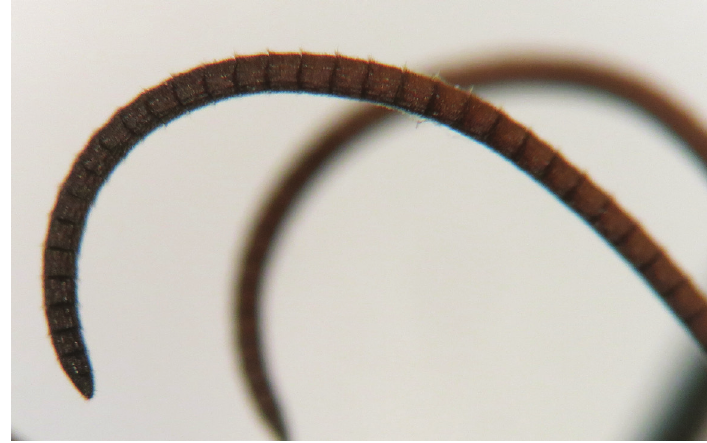
Figure 10. Heinrichiella obscura comb. n., apical half of male antenna